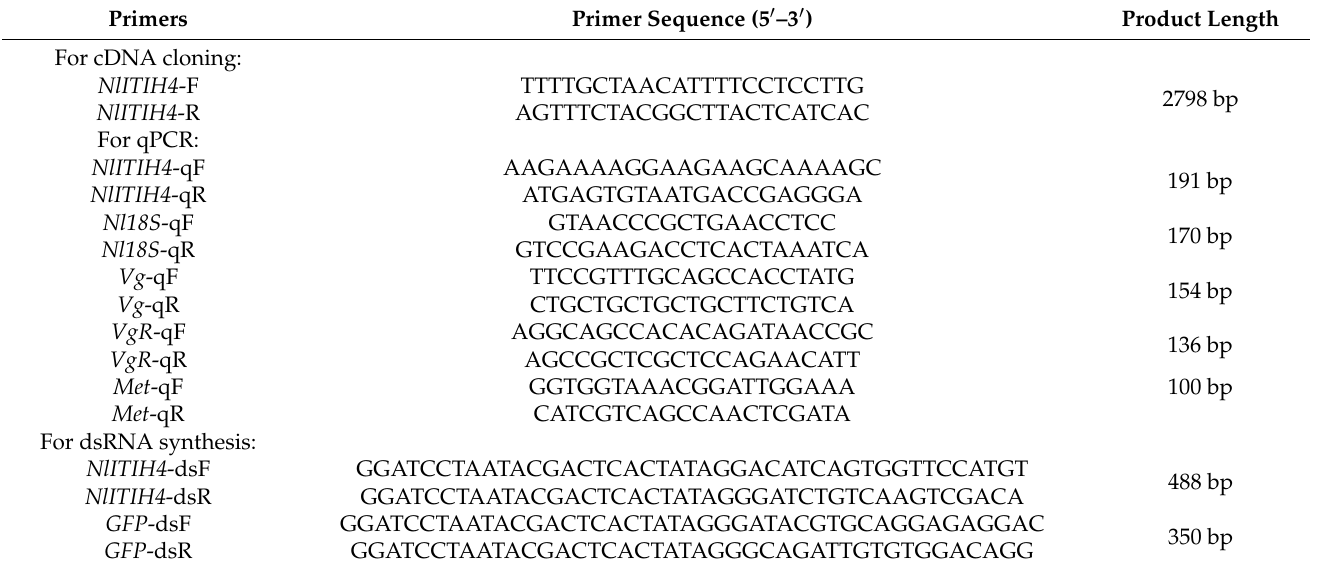
Table 1. The primers used in this